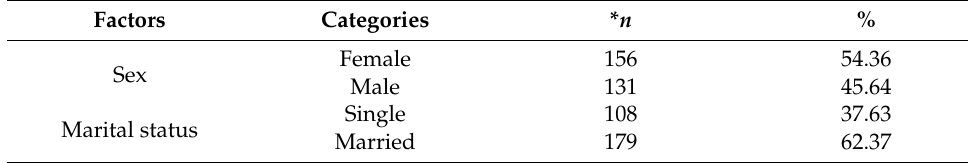
Table 1. Participants’